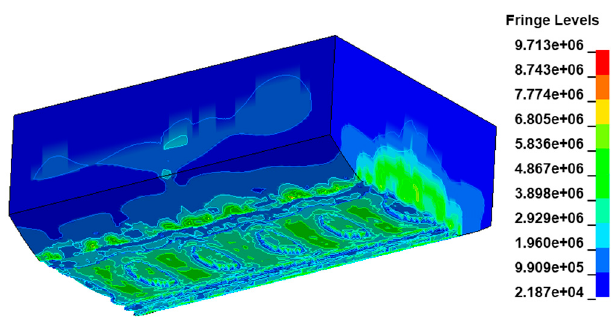
Figure 21. Stress contours of ice block in the simulation.